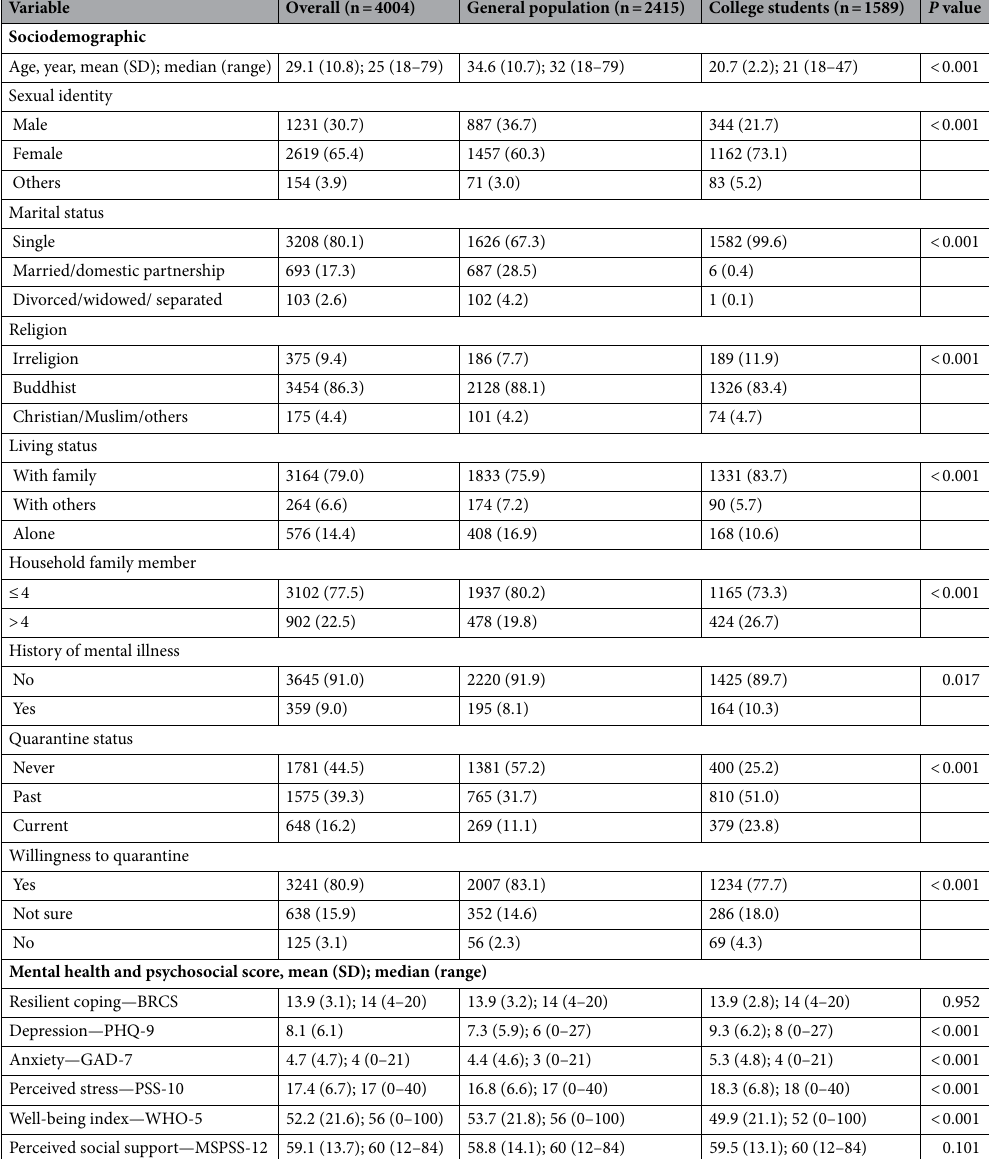
Anxiety Disorder—7-items, MSPSS-12 Multidimensional Scale of Perceived Social Support—12-items, PHQ-9 Patient Health Questionnaire—9-items, PSS-10 Perceived Stress Scale—10-items, SD standard deviation, WHO-5 World Health Organization Five Well-Being